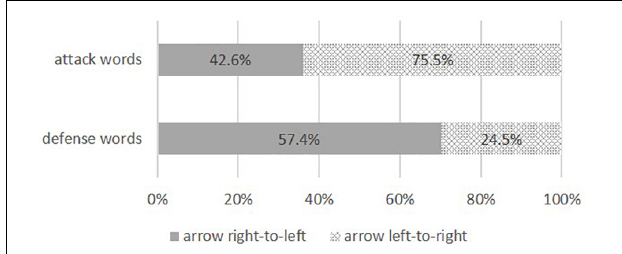
FIGURE 1 | Percentage arrow alignment Study